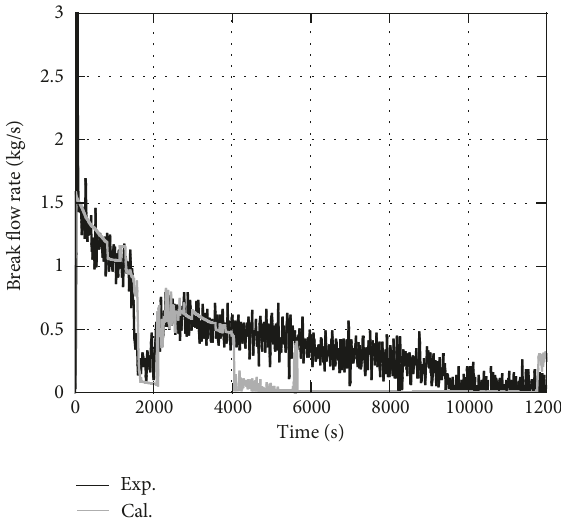
Figure 14: TR-LF-17 test and RELAP5 results for break flow rate.